Question: Describe this figure in one sentence.
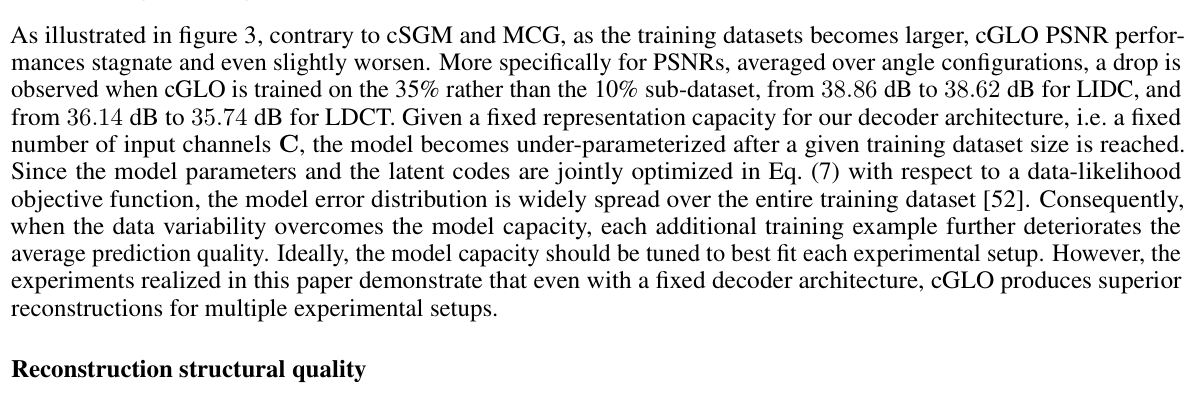
Answer: compares reconstructions computed with cGLO, cSGM and MCG from the LIDC test dataset. Reconstruction quality clearly degrades as the number of experimental viewing angles diminishes. The type of degradation, however, differs between cGLO and the score-based methods cSGM and MCG. While cGLO reconstructions lack sharp details and get noisier for very sparse CT or when trained on very small datasets, cSGM and MCG tend to alter the structural integrity of the slices. This observation corroborates and explains the total dominance of cGLO over all the methods when comparing median SSIM curves rather than median PSNR curves in figure 3.